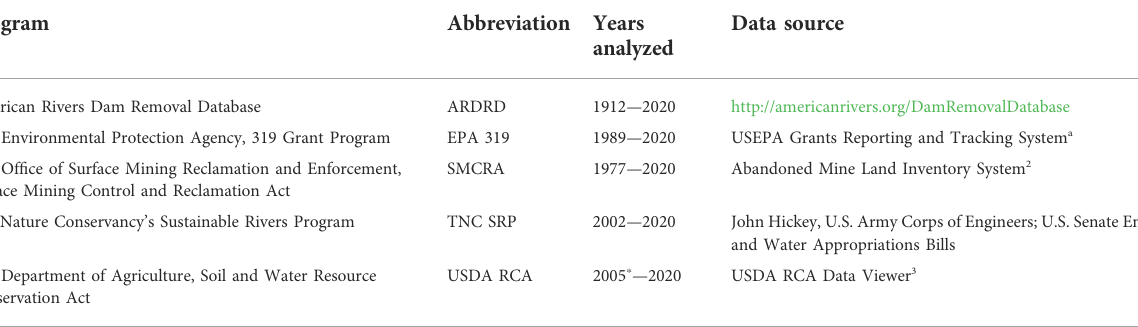
TABLE 1 Summary of data availability and data sources for the fi ve conservation programs analyzed. The USDA RCA program began in 1977, but program data were available only for the period 2005 to 2020.